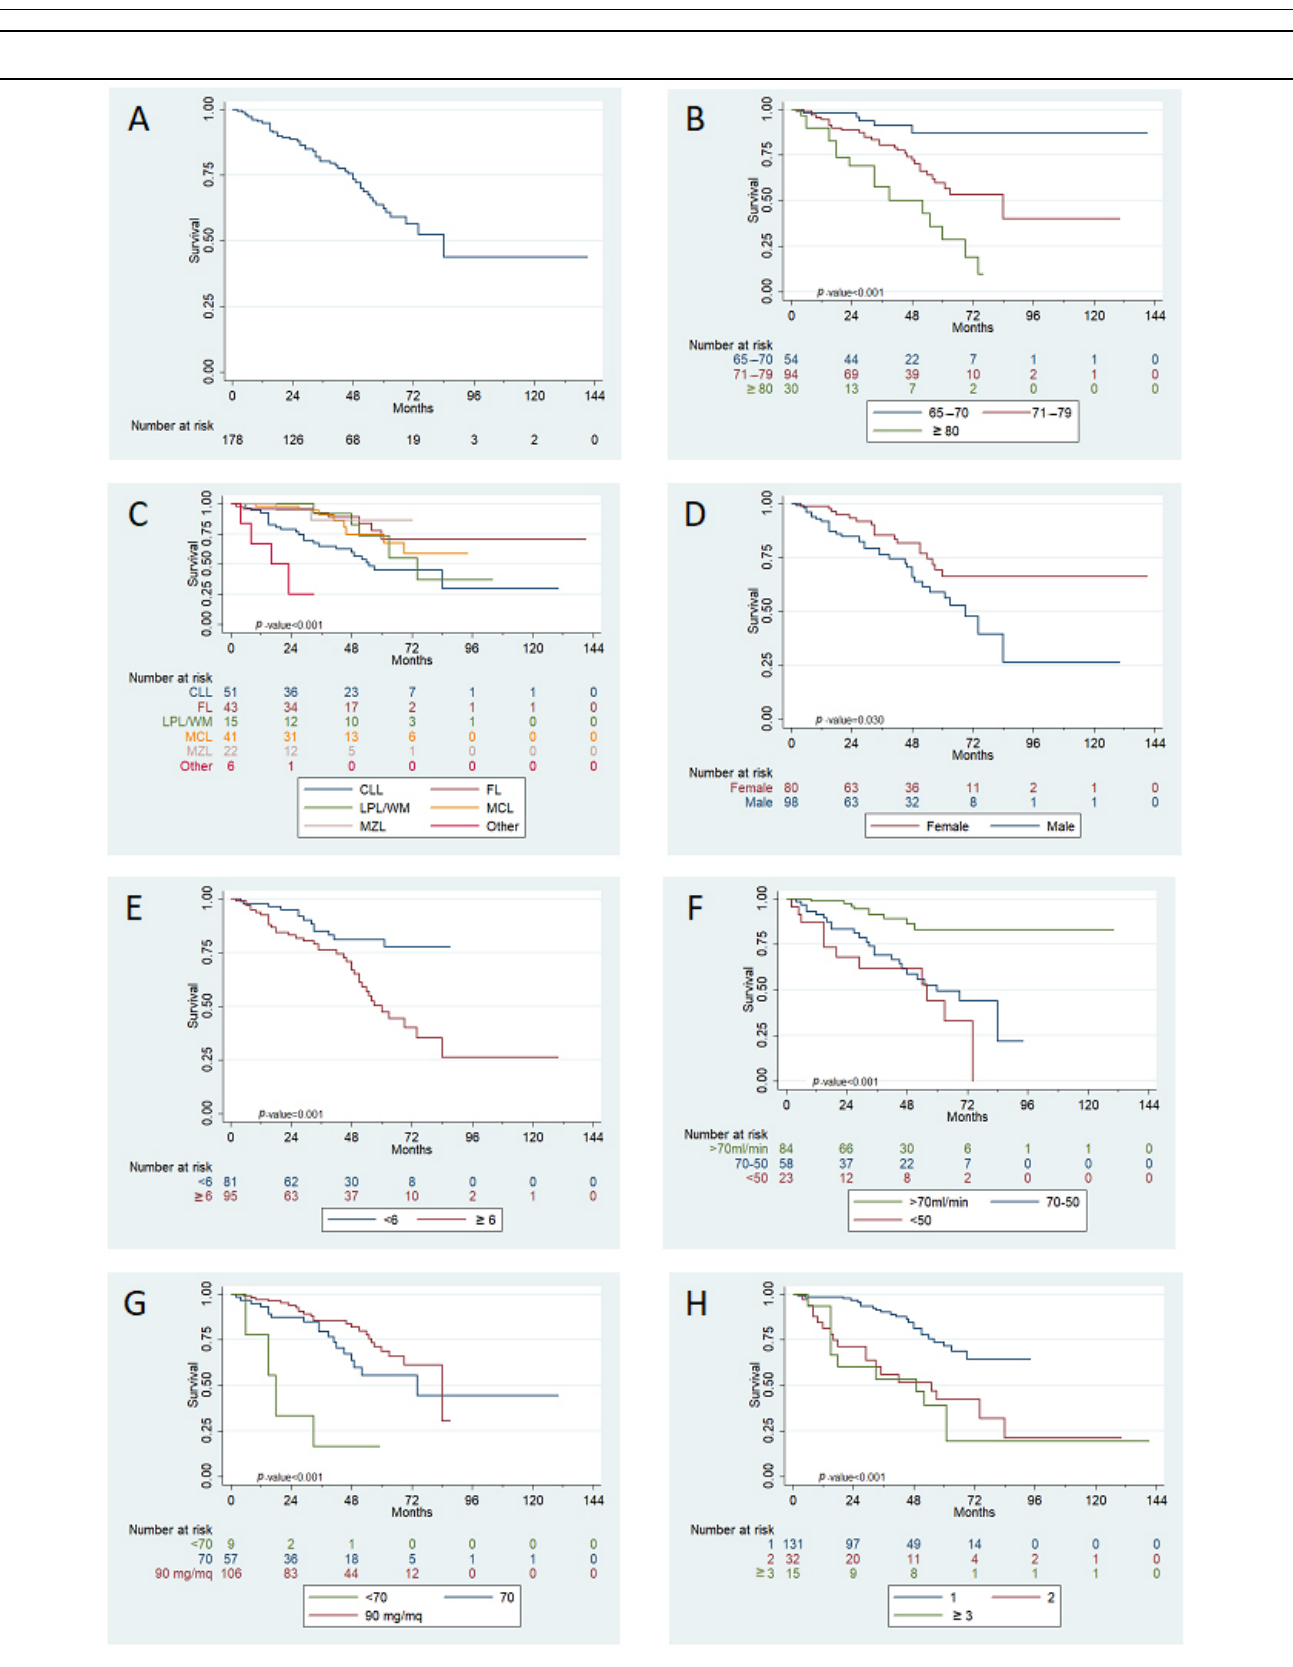
Figure 2. Univariate analysis for OS. panel ( A ): median OS after bendamustine-based treatment initiation, overall series; panel ( B ): OS according to different age classes; panel ( C ): OS stratified accoding to initial diagnosis; panel ( D ): OS divided by patients’ sex; panel ( E ): OS according to CIRS score; panel ( F ): according to BCC at baseline; panel ( G ): effect of bendamustine dose received on OS; panel ( H ): OS stratified according to line of therapy at bendamustine